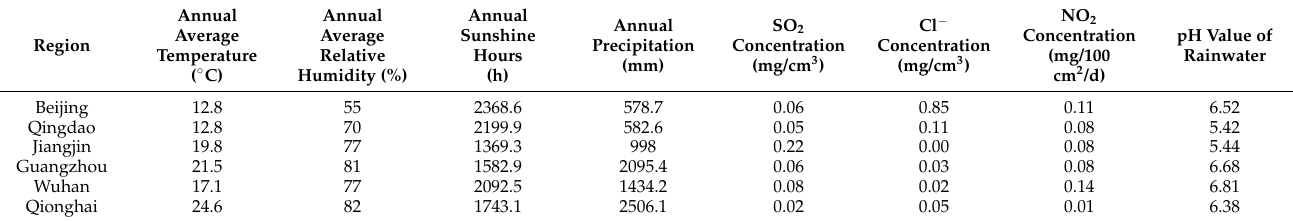
Table 6. Meteorological data of each region.